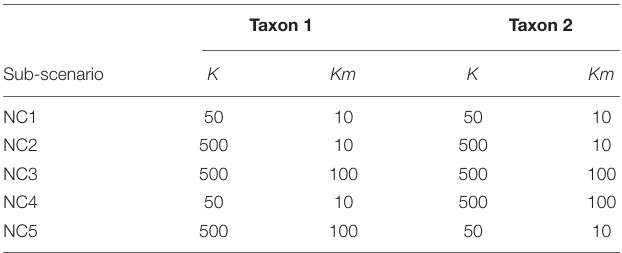
TABLE 1 | Simulated sub-scenarios with different parameter values of demography and migration during the range expansion of an invasive taxon and hybridization with a local taxon (see Figure 1